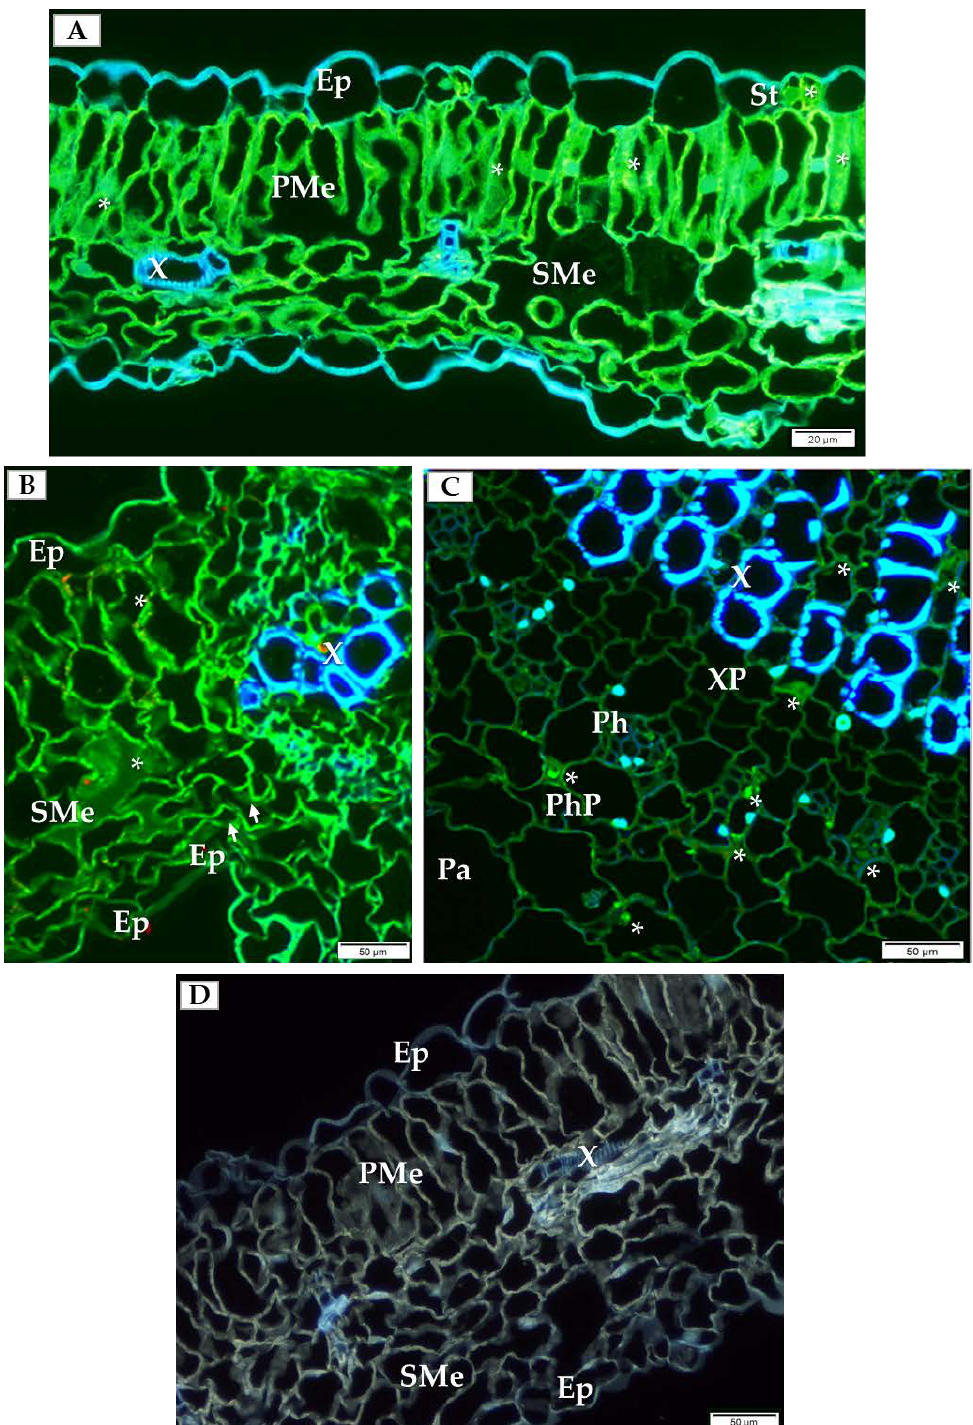
Figure 2. Immunofluorescence localization of PDV-coat protein (PDV-CP) epitopes in the infected cucumber leaf tissue of Polan variety (14 dpi). ( A ) Localization of the epitopes of PDV-CP (green fluorescence, marked with *) in stomata and palisade mesophyll cells (14 dpi), Bar 20 µm; ( B ) PDV-CP epitope (*) inside spongy mesophyll (14 dpi). Deformations of cell wall in spongy mesophyll cell are marked with white arrows, Bar 50 µm; ( C ) Cross section of cucumber leaf through main vein with presence of CP (*) in xylem and phloem parenchyma (14 dpi), Bar 50 µm; ( D ) Section of mock-inoculated leaf without PDV-CP, Bar 50 µm. Abbreviations: Ep—epidermis, St—stomata, PMe—palisade mesophyll, SMe—spongy mesophyll, Pa—parenchyma, X—tracheal element, XP—xylem parenchyma, Ph—phloem, PhP—phloem parenchyma.